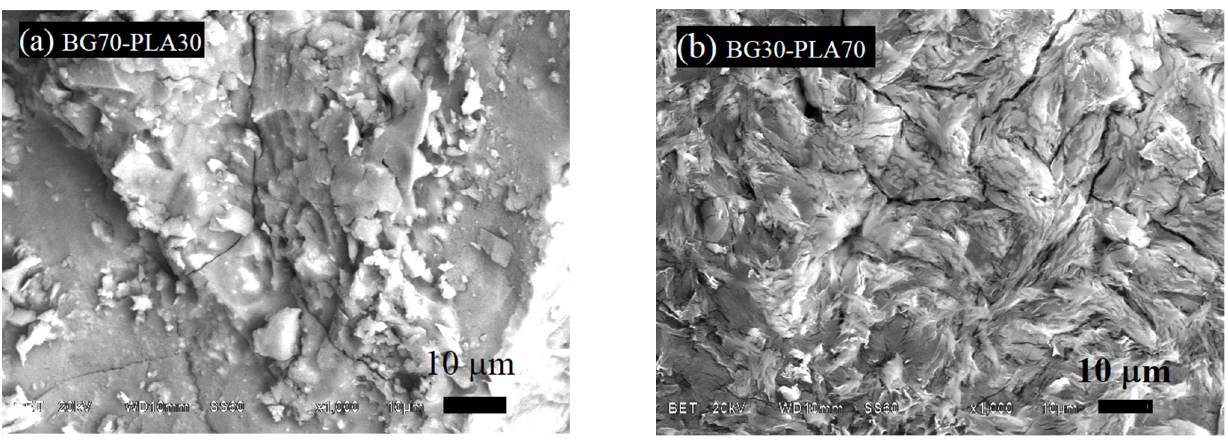
Figure 8. Scaffold SEM analysis for ( a ) BG70-PLA30 and ( b ) BG30-PLA70. Table 3. Energy-dispersive X-ray spectroscopy for both compositions.